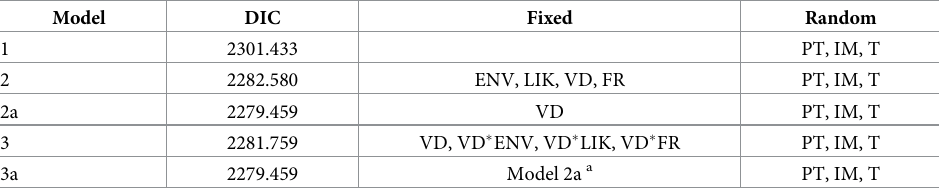
Table 3. Model fit comparisons for models with standardised velocity as a dependent variable.